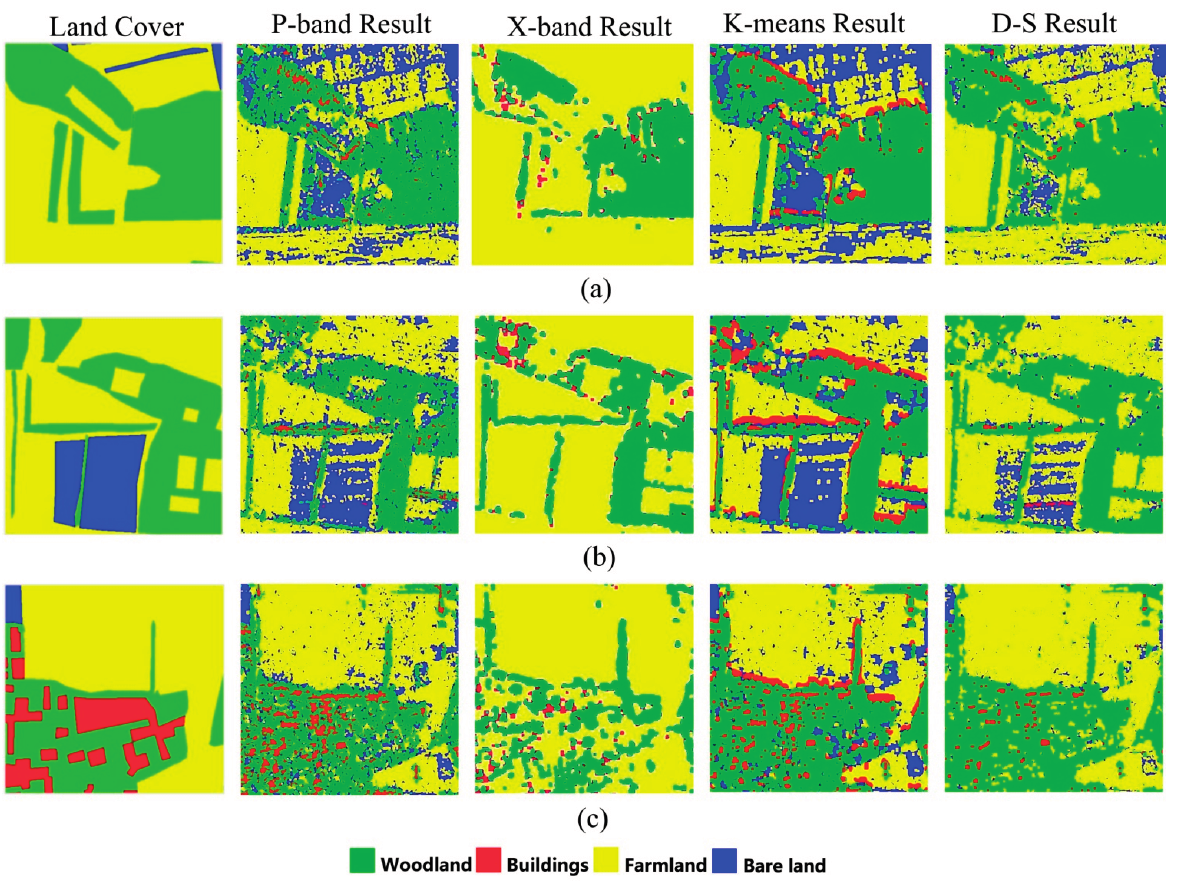
Figure 11. Comparison of the land cover, the classification results of the P- and X-band images, and the two fusion results. ( a ) Region A. ( b ) Region B. ( c ) Region